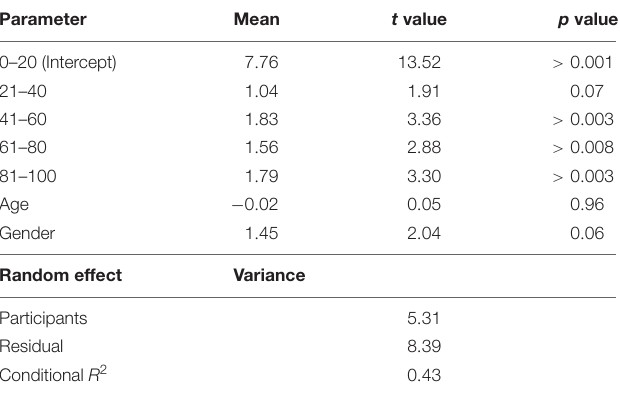
TABLE 2 | Estimated parameters using the regression model.